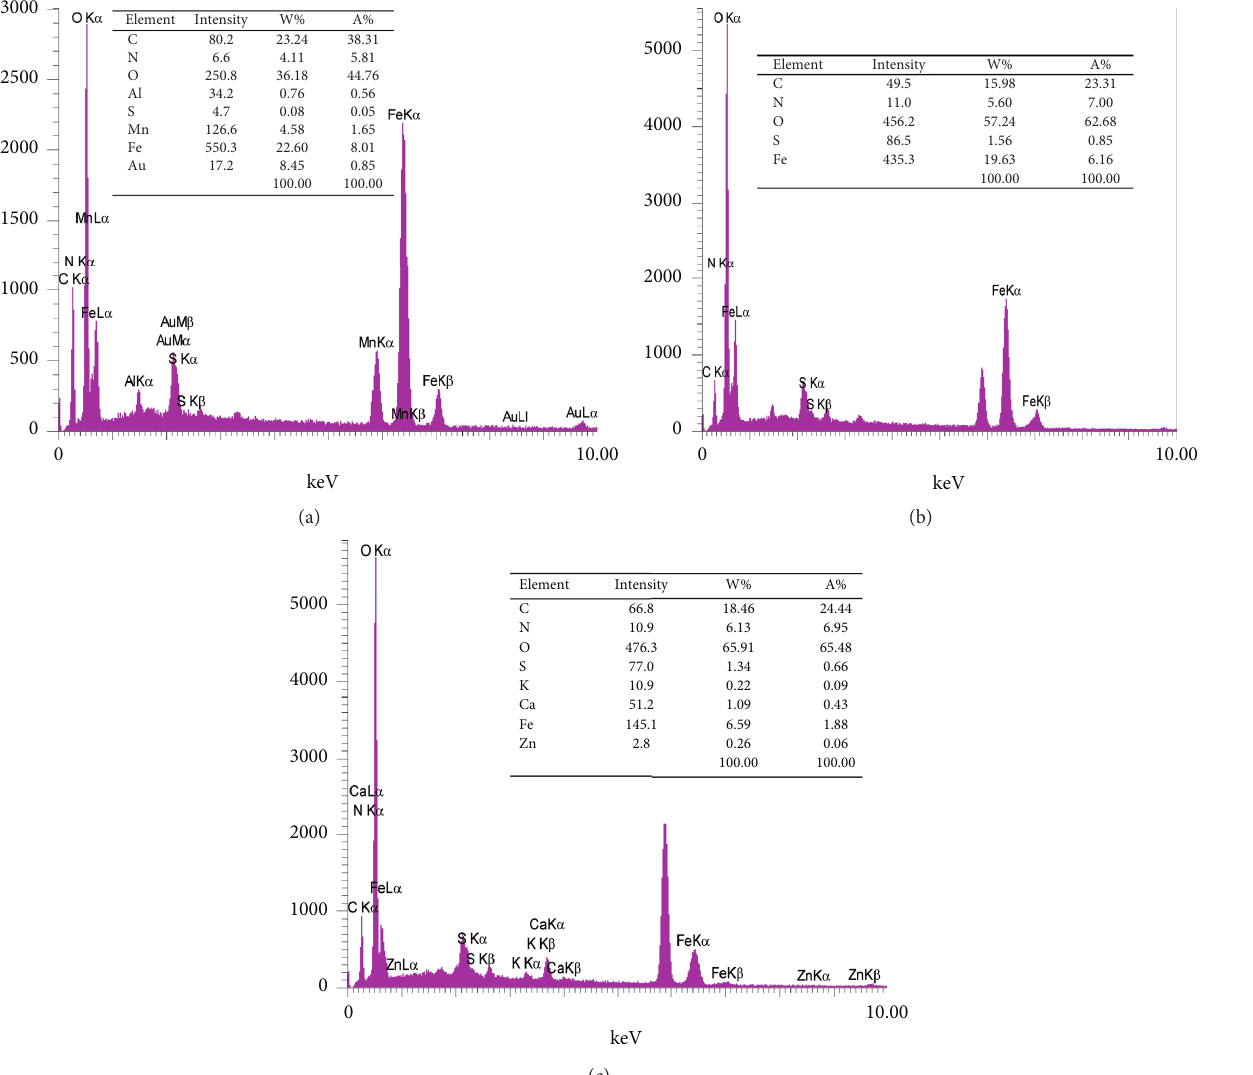
Figure 3: EDX analysis of (a) PR-Fe 3 O 4 , (b) PR-GO-Fe 3 O 4, and (c) modified PR-GO-Fe 3 O 4 with kombucha